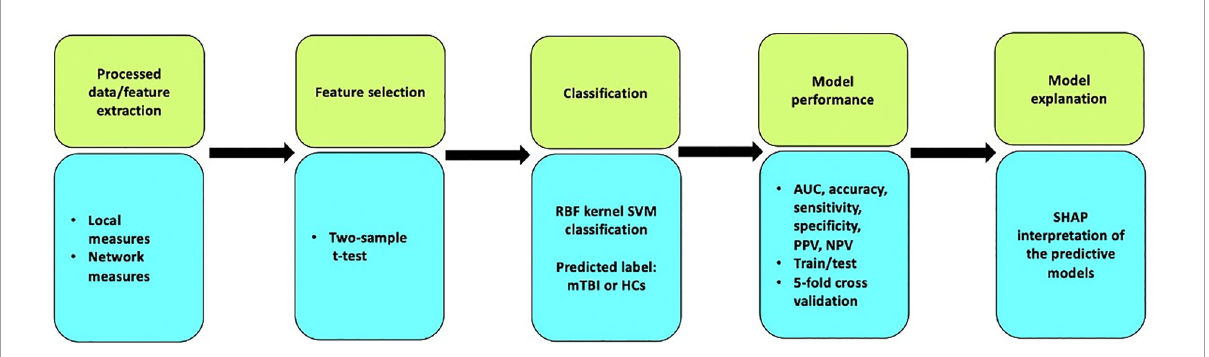
FIGURE1 Workflow of the study including five main steps: data processing, feature extraction using statistical two-sample t -test, classification, model performance, and model interpretation.